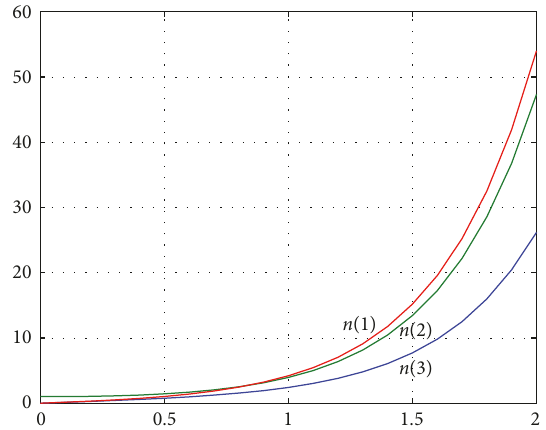
Figure 6: Evolution curve of variables when the initial state set as [1, 1,0] .